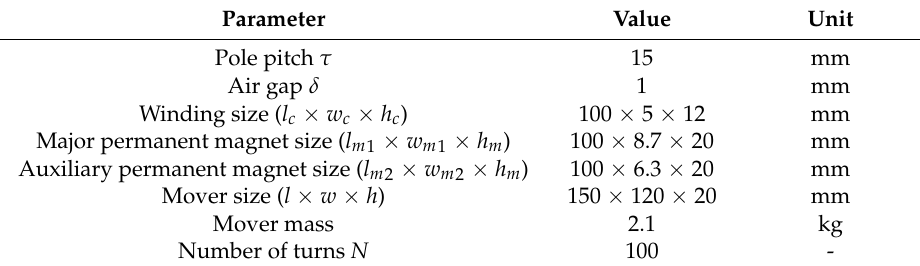
Table 2. Motor major